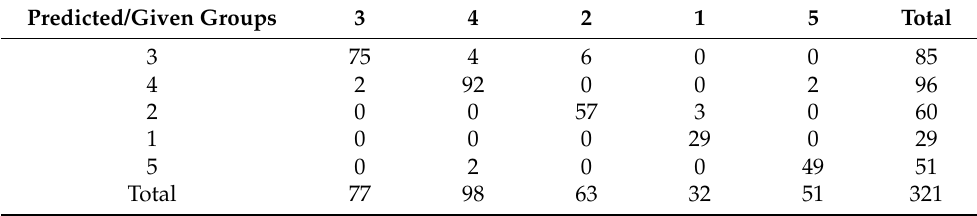
Table 1. Confusion matrix associated with the performed discriminant analysis. Predicted/Given